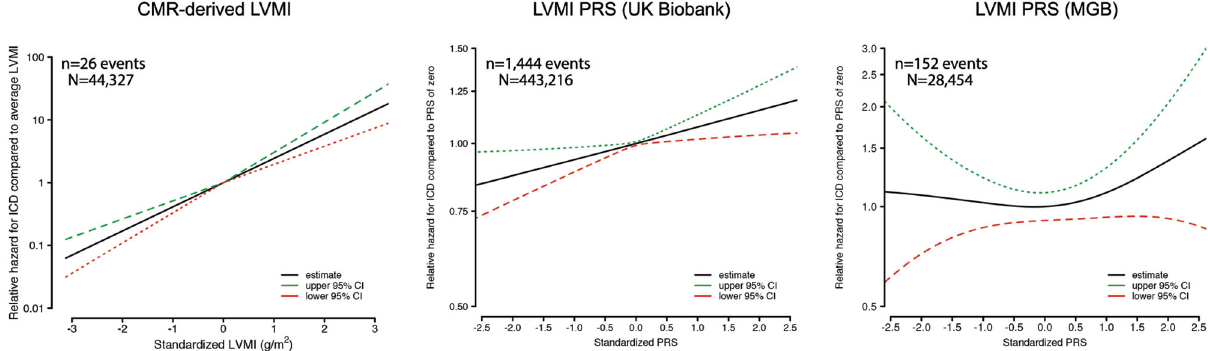
Fig. 5 | Association between CMR-derived and genetically predicted LVMI and incident ICD implant. Depicted are plots showing the relative hazard of incident implantable cardioverter-de fi brillator (ICD) implant as a function of increasing standardized CMR-derived LVM index (left), increasing standardized LVMI PRS in UK Biobank (middle) and increasing standardized LVMI PRS in Mass General Brigham(MGB,right).Ineachplot,they-axisdepictstherelativehazardofincident ICDcomparedtothehazardobservedforindividualswithanaverageLVMI(left)or average PRS value (middle and right), derived from Cox proportional hazards